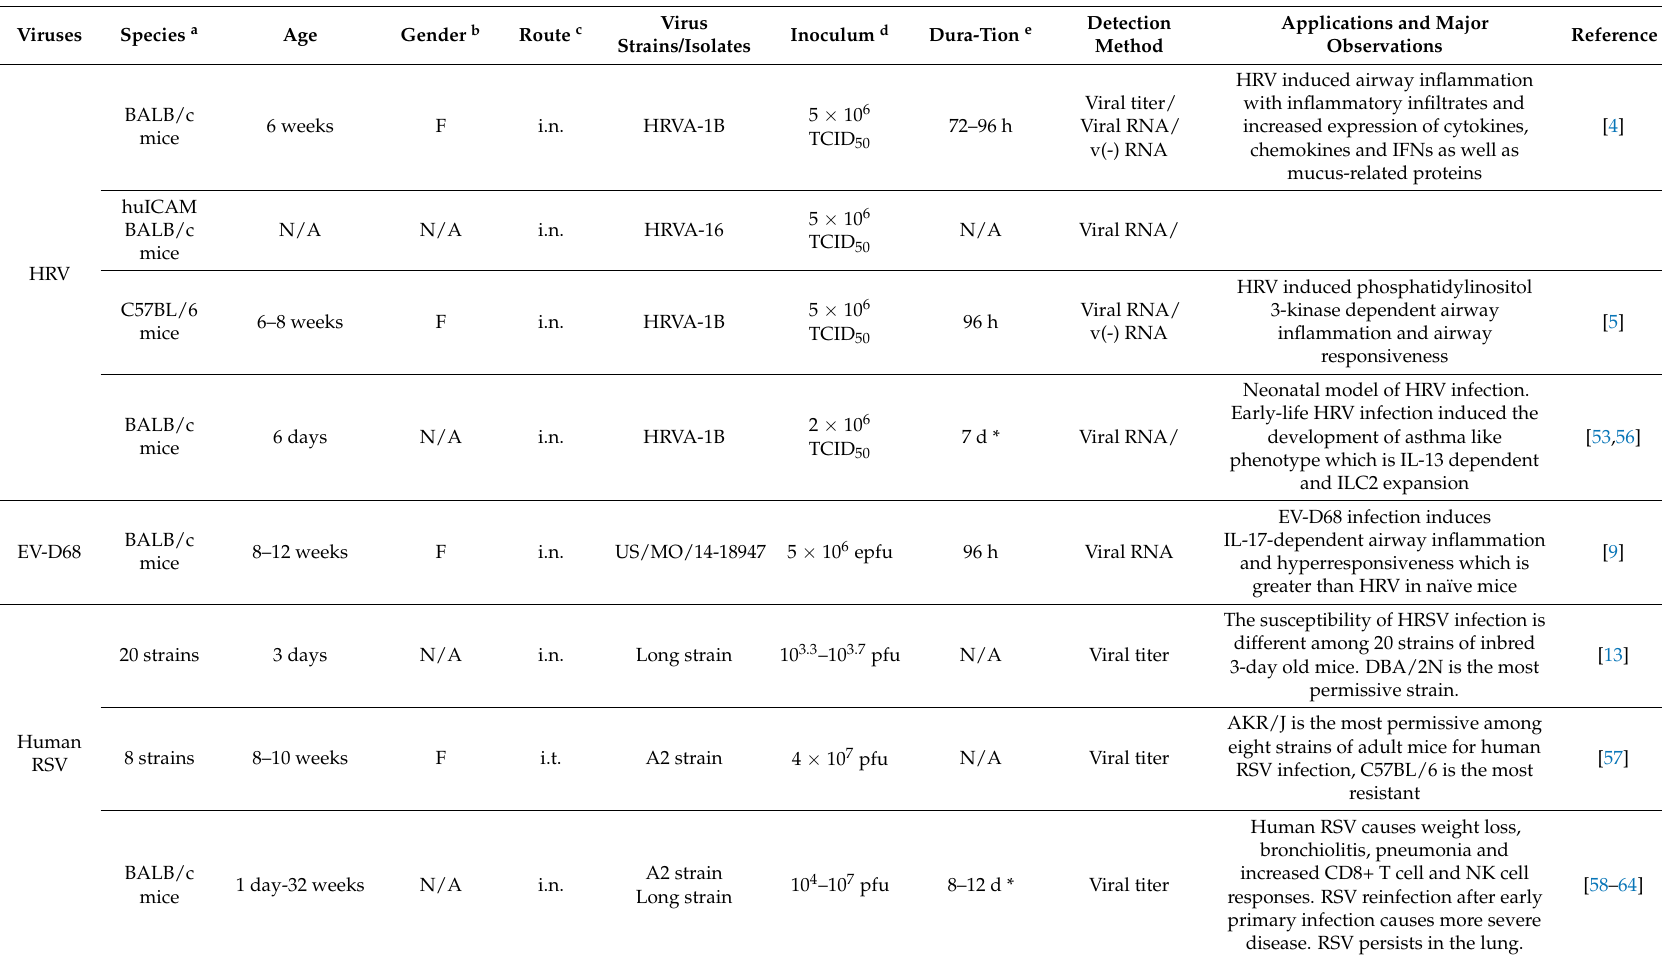
Table 2. Mouse models for respiratory viral